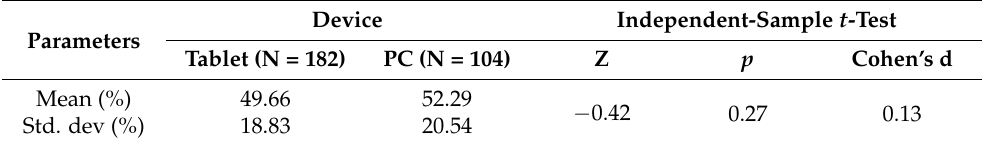
Table 9. Digital test of visual communication: “produce” domain: scores of tablet and personal computer